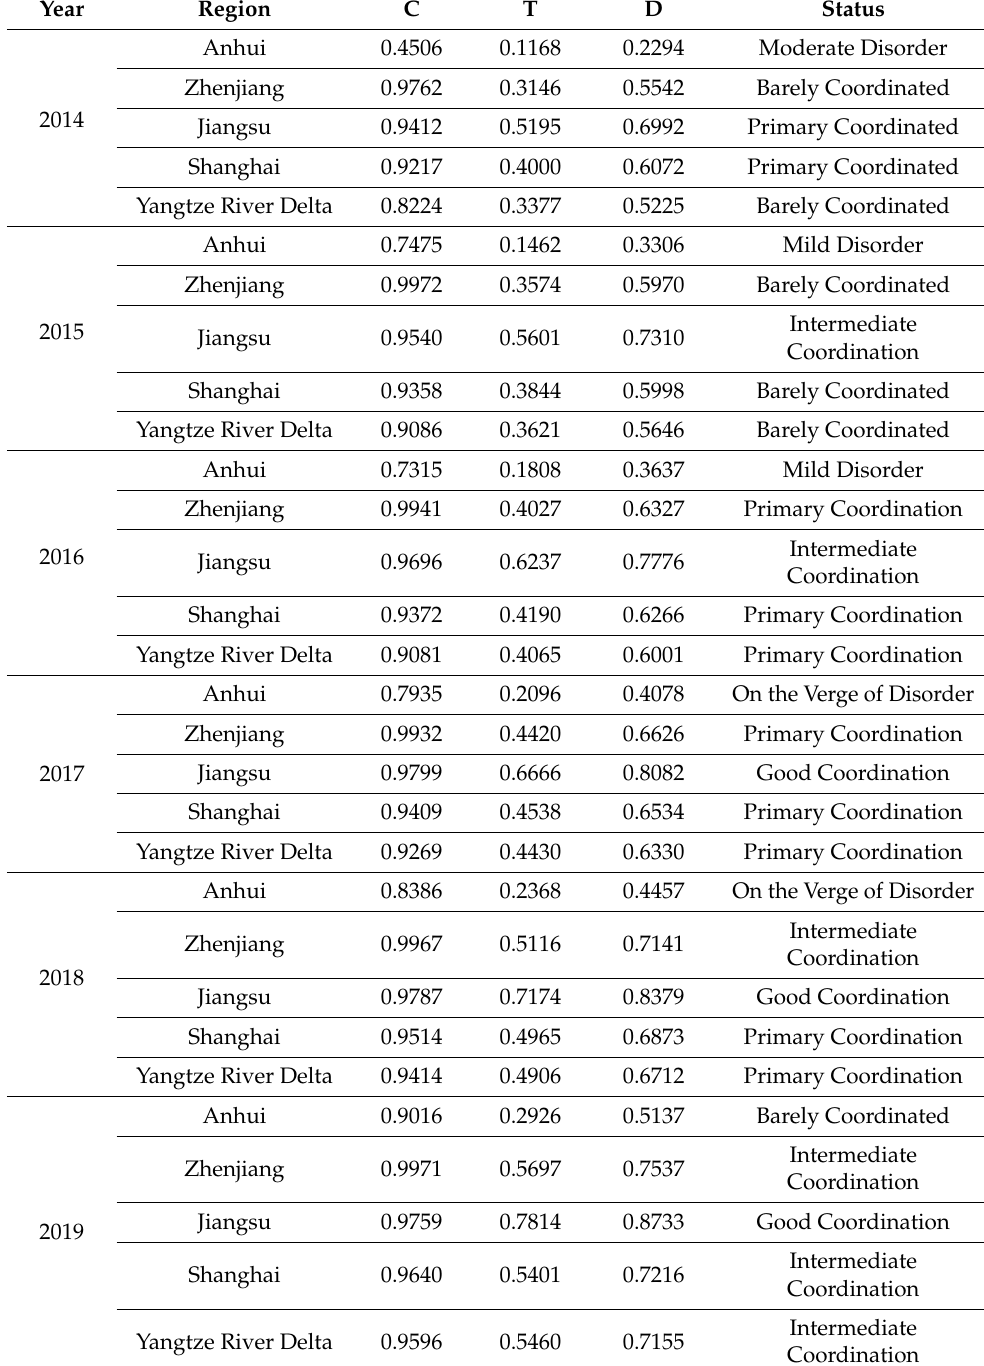
Table 5. Coupling degree and coordination degree of the regional innovation EROB composite system in the YRD